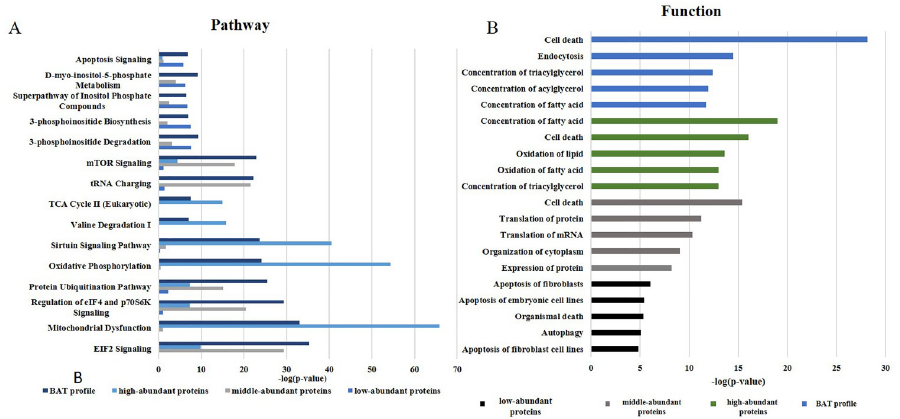
Fig 3. IPA analysis of the BAT proteome profile. (A) The top canonical pathways of BAT proteins. (B) Major functions of BAT